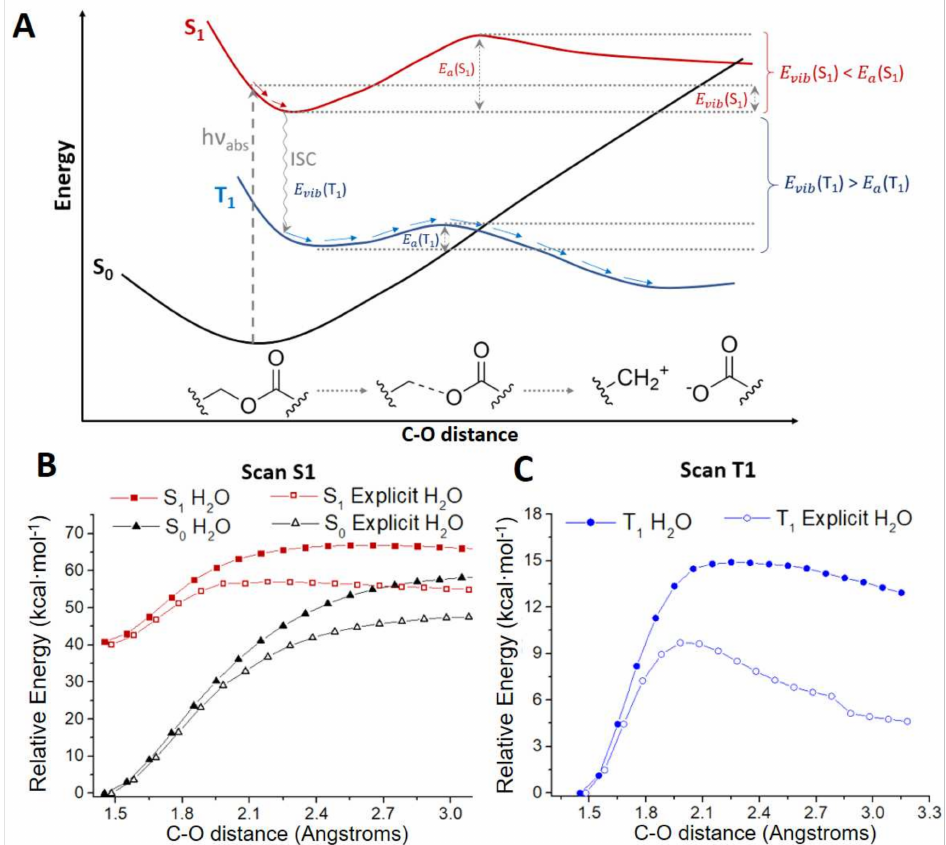
Figure 4. ( A ) General scheme of the photorelease mechanism computed for compounds 2 , 4 and 5 . ( B ) Scan computed in S 1 and ( C ) T 1 along the C-O distance considering the solvent (water) implicitly (filled symbols) or explicitly (empty